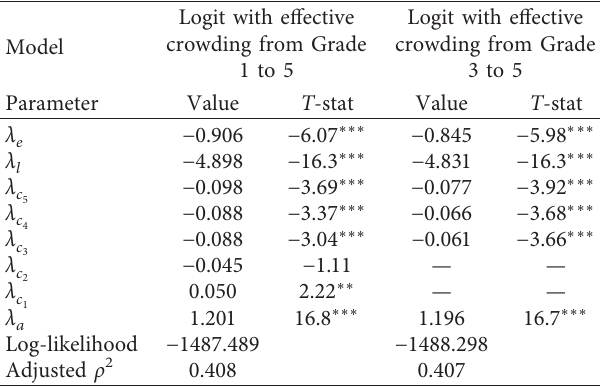
Table 10: The estimates of logit-based departure time choice models with different effective crowding